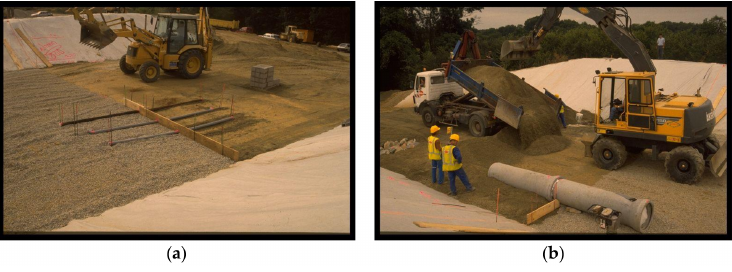
Figure 12. Placement of ( a ) one of the pipe series in the gneiss sections, and ( b ) the 500-mm concrete